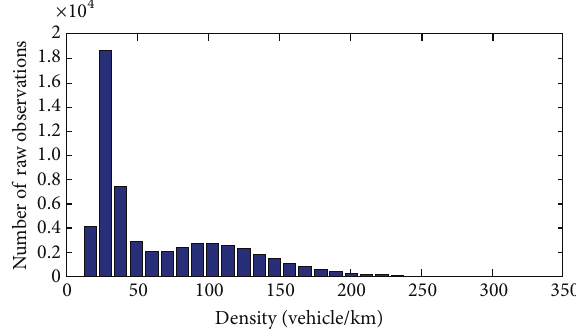
Figure 2: Curve computed from function (8).